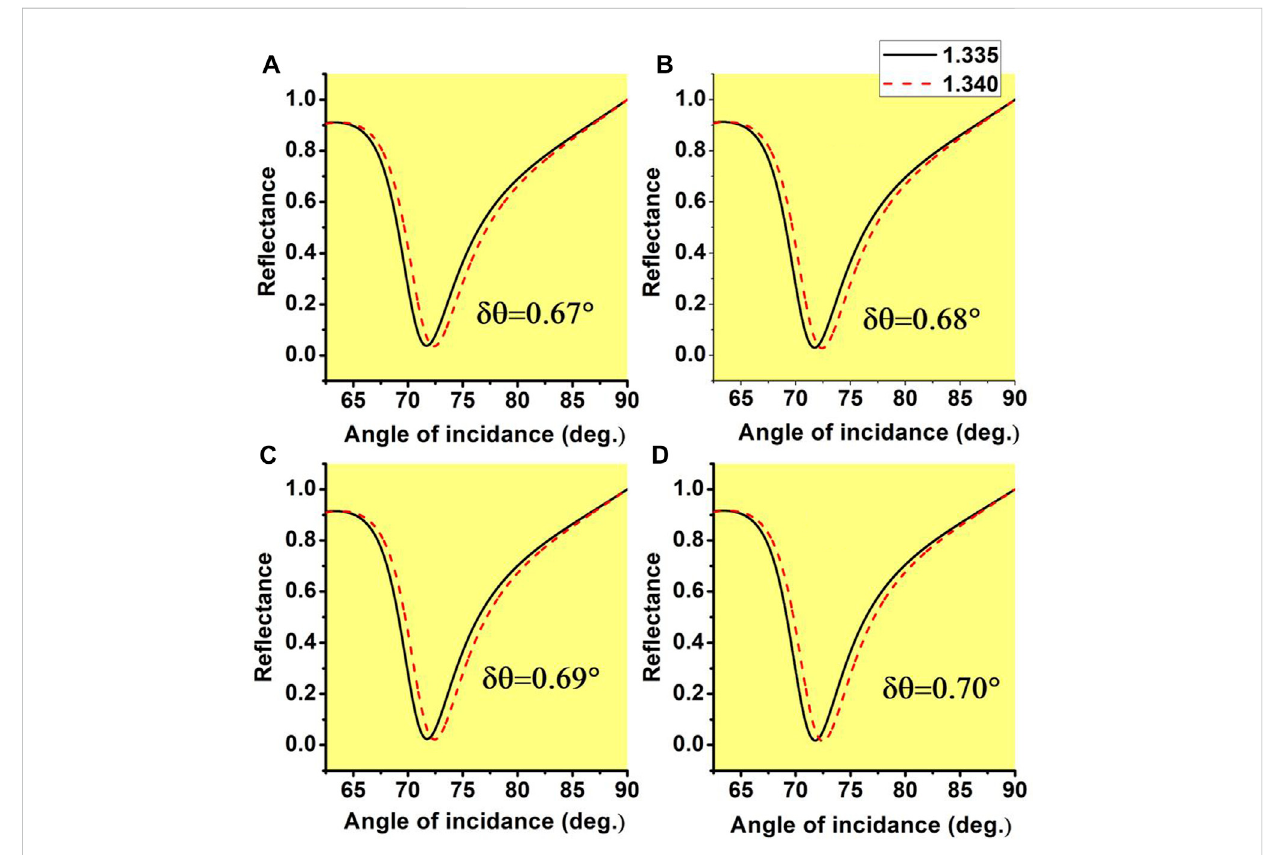
FIGURE 3 The variation of the re fl ectance with the angle of the incidence of the prism for the two RI of the analyte 1.335 and 1.340 when the thickness of the adhesion layer of MgO is considered as (A) 0 nm (B) 5 nm (C) 10 nm (D) 15 nm.